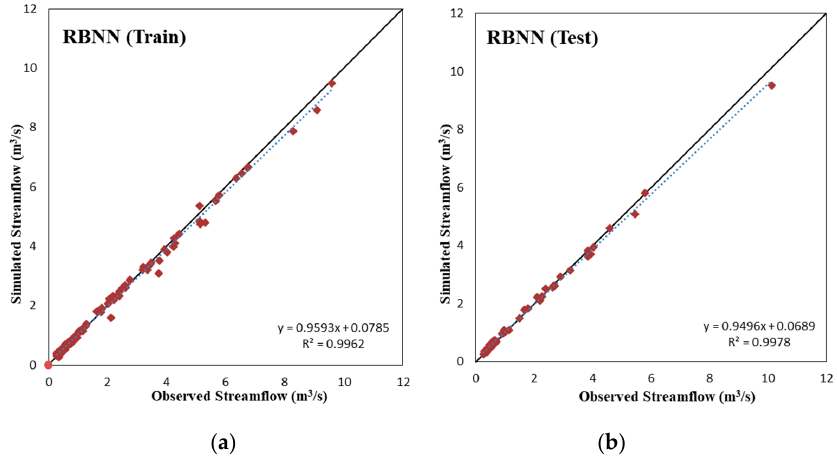
Figure 6. RBNN scatter plots: ( a ) train; ( b ) test.